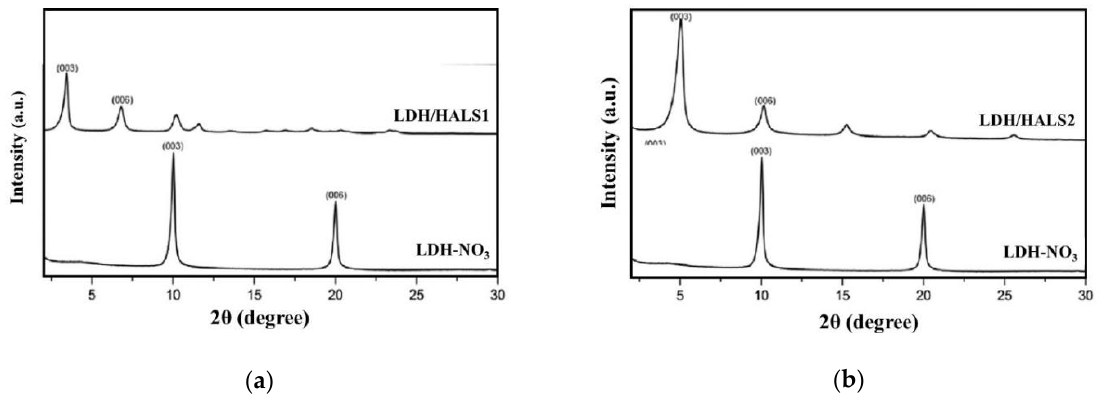
Figure 2. WAXD patterns of ( a ) LDH-HALS1 and ( b ) LDH-HALS2 in comparison to the pattern of LDH-NO 3